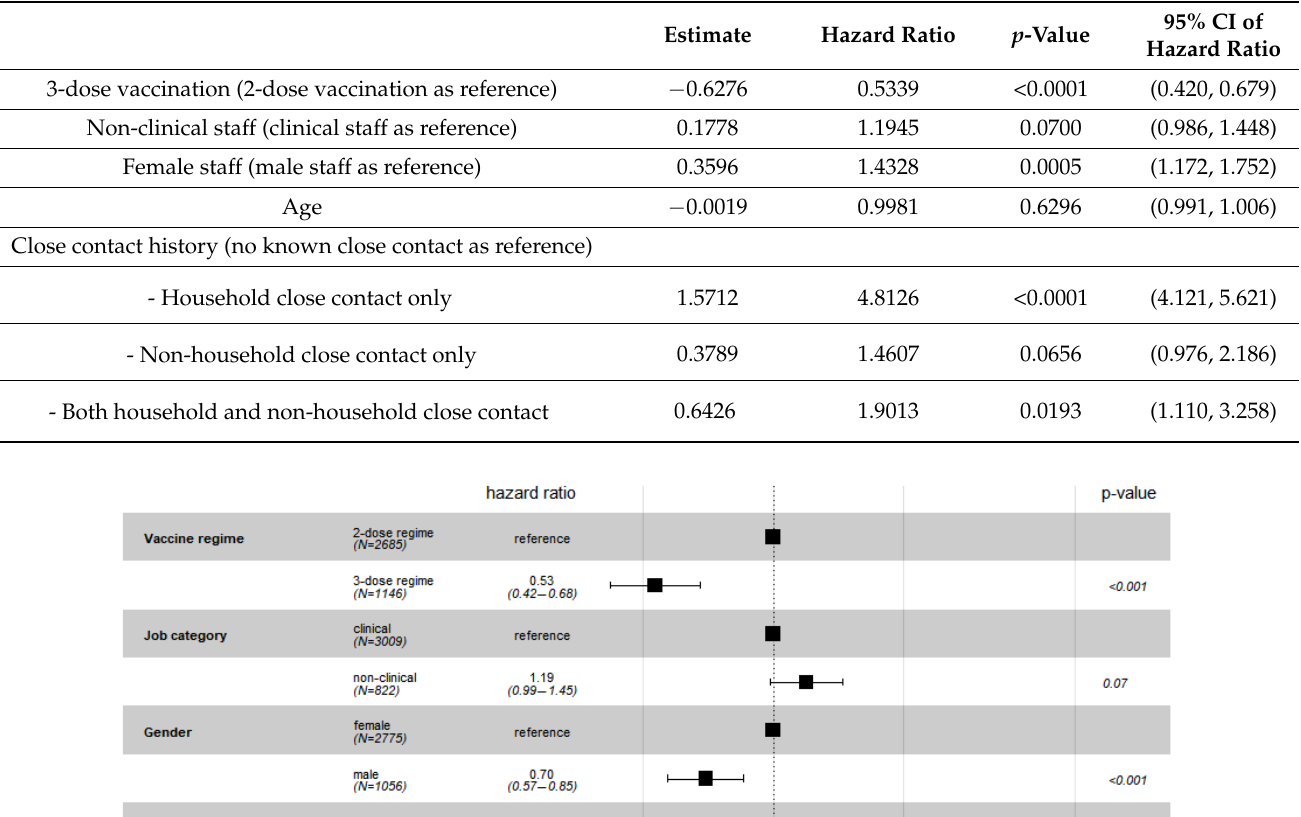
Table 4. Time-dependent Cox regression analysis on the risk of acquiring COVID-19.